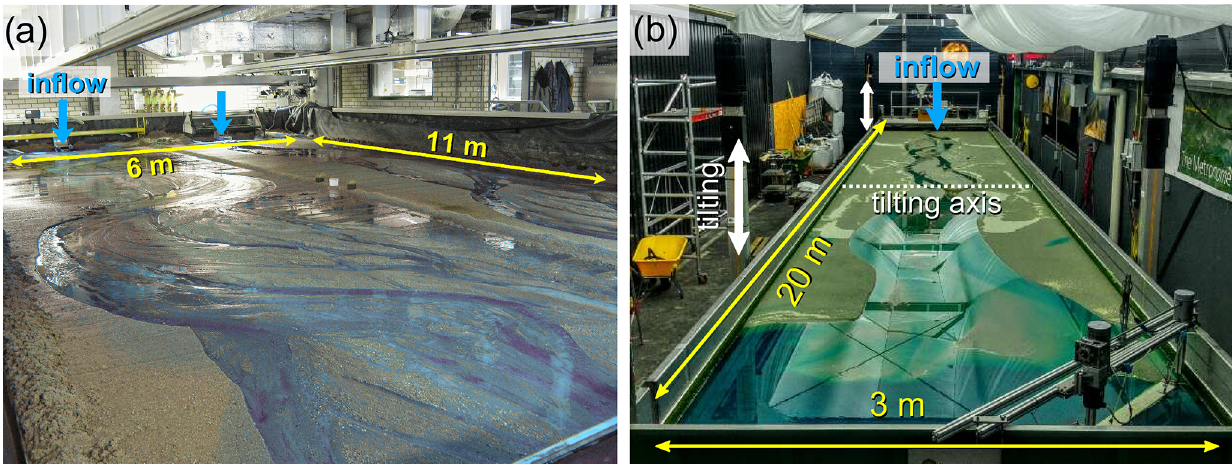
Figure 2. The flume setups of the two scale experiments tested in this study. (a) The Eurotank flume was used to simulate meandering and braided rivers in parallel on the left and right part of the flume, respectively (Van Dijk et al., 2013a). Water colour was converted to blue for visual comparison with (b) the second scale experiment in the tilting flume the Metronome that was used to simulate estuaries (Leuven et al., 2018). The flume is tilted over the short central axis, which steers flood and ebb flows that favour ample sediment transport in both tidal